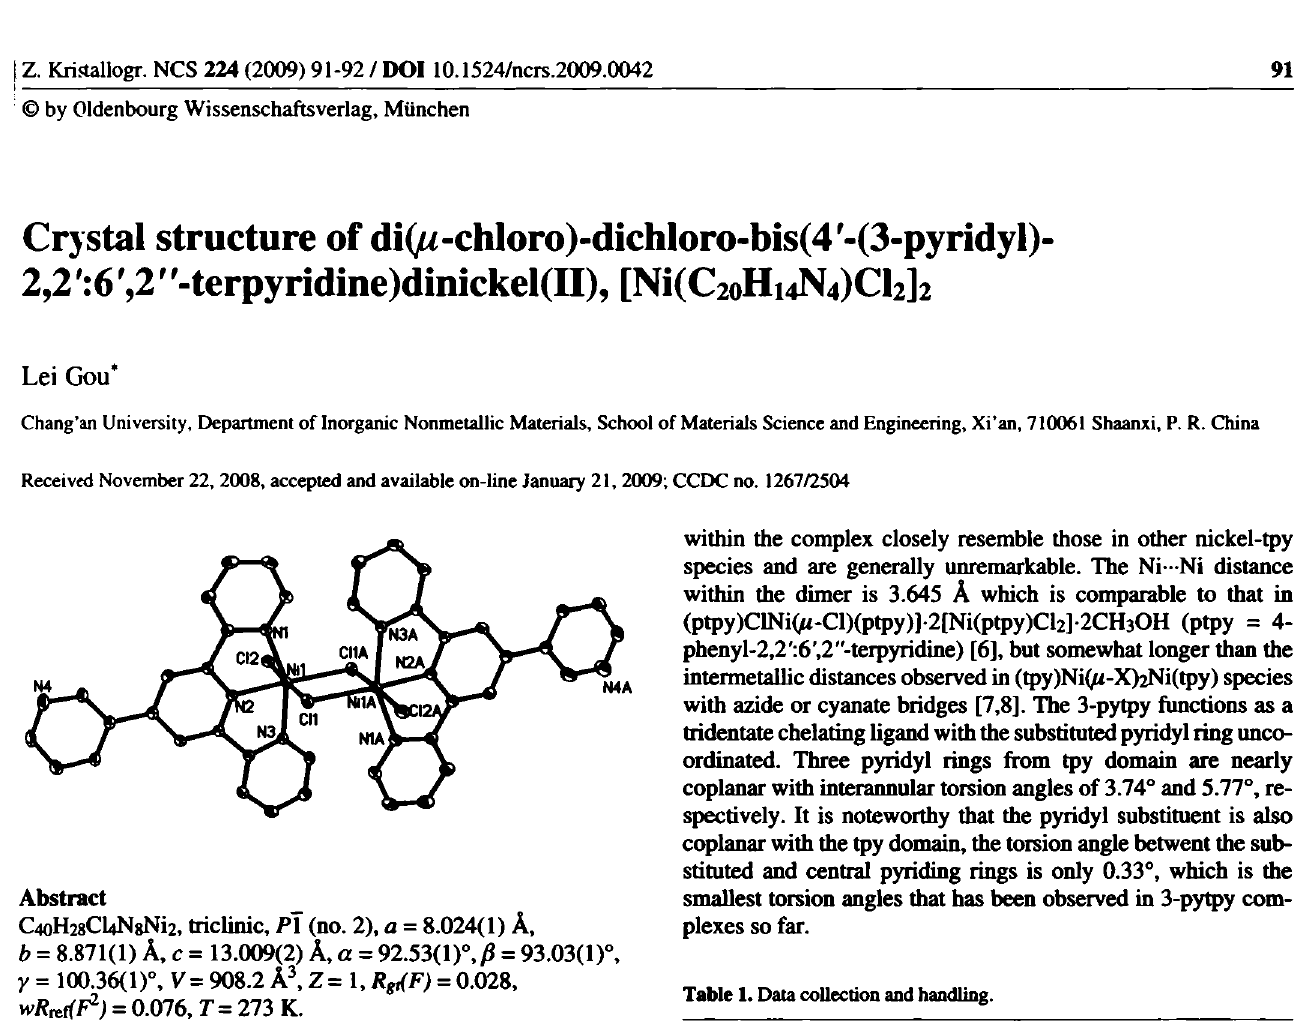
Table 1. Data collection and handling.